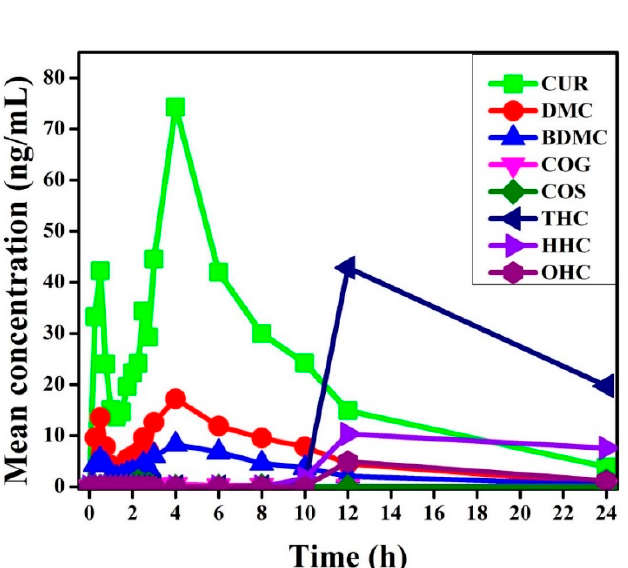
Figure 8. Pharmacokinetic profiles of CUR, DMC, BDMC, COG, COS, THC, HHC and OHC concentration in plasma at different time intervals after administration of a single dose of Cureit™ (500 mg/day).